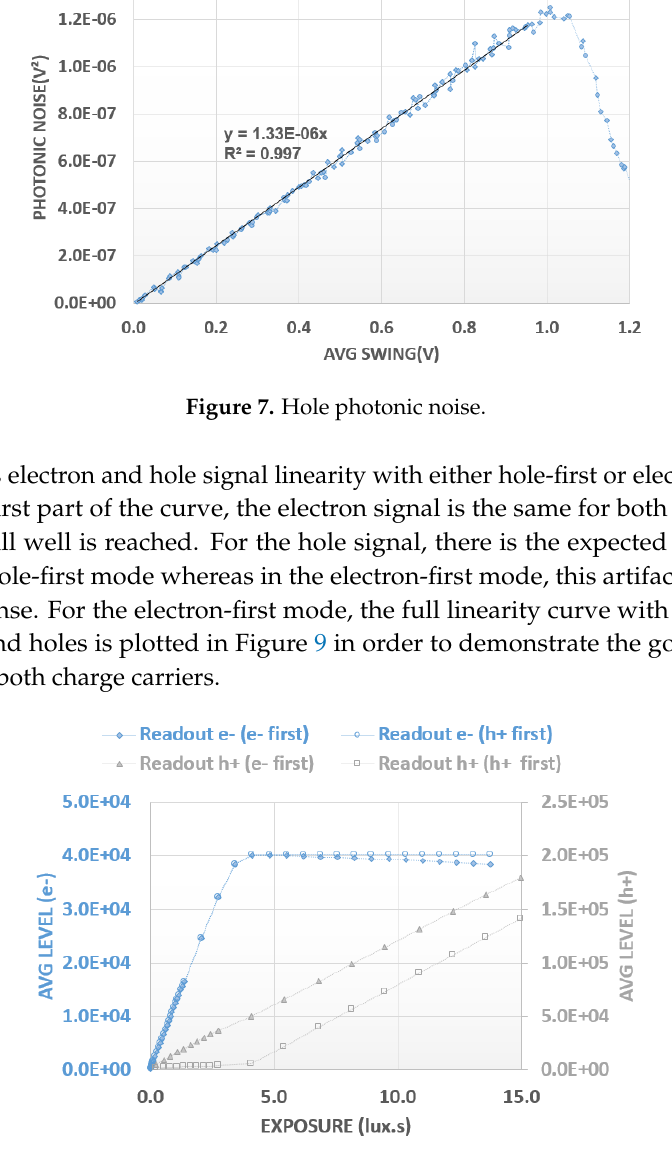
Figure 8. Linearity versus readout mode.